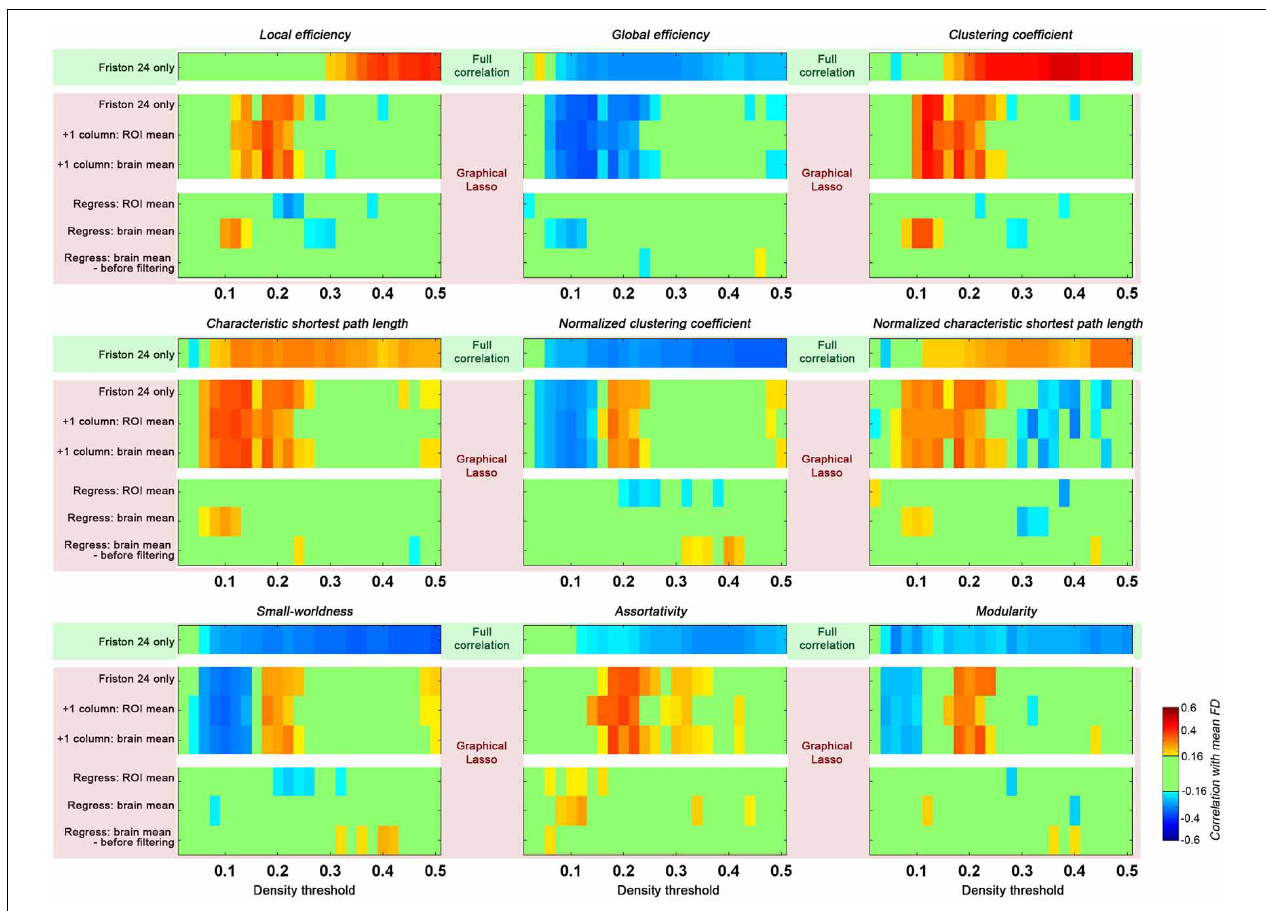
FIGURE 7 | Impact of graphical lasso (partial correlation) on head motion relationships with global topological parameters. The head motion effects of full correlation was demonstrated as a base (green shaded, based on Friston 24 model), while different implementation of graphical lasso was implemented based on the Friston 24 model (pink shaded). Two scenarios were created to test the GSR effect with graphical lasso: (1) the global signal